Question: Write a single sentence explaining what this figure depicts.
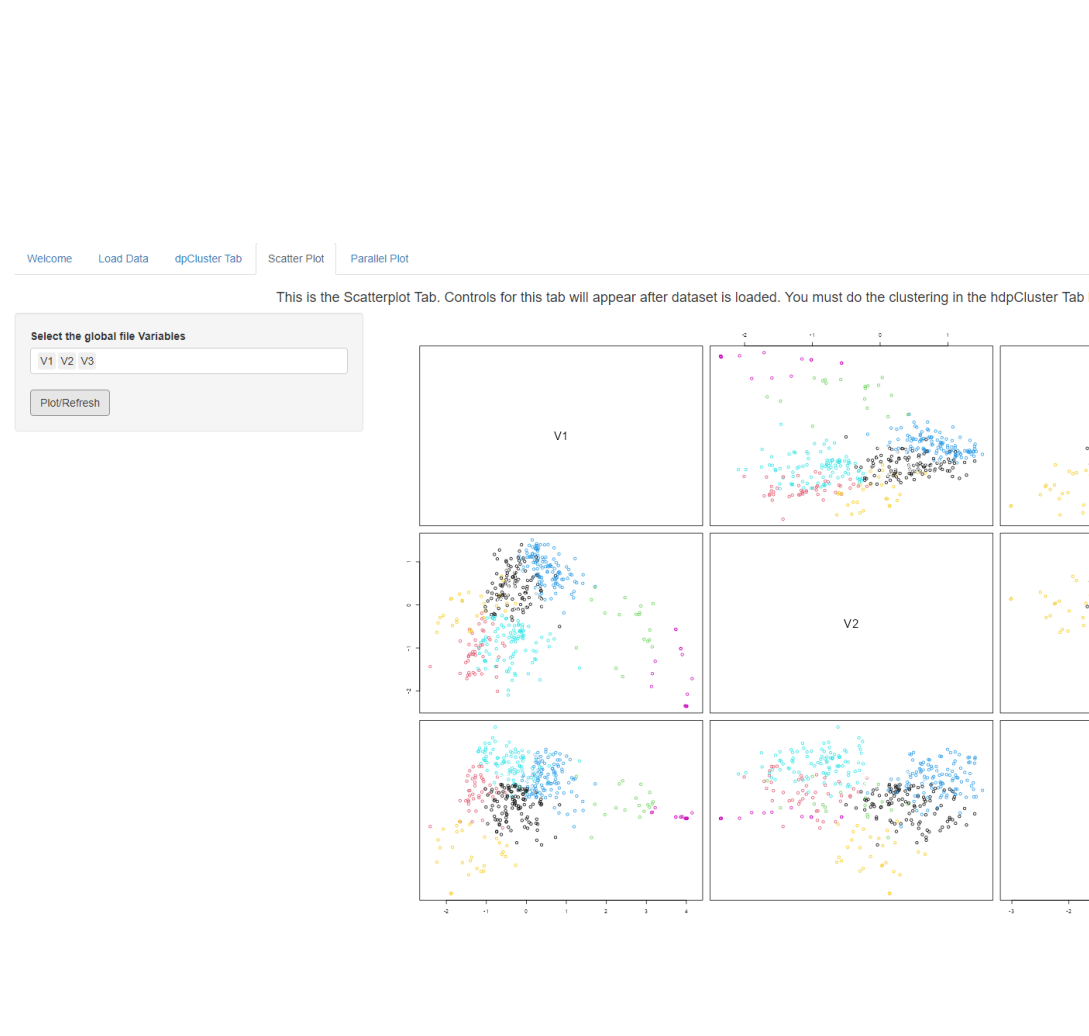
Answer: The cluster results can be viewed in the Scatter Plot tab. Here we see clusters  found in the MLR data. The colors indicate the cluster, and the groups seem visually reasonable.